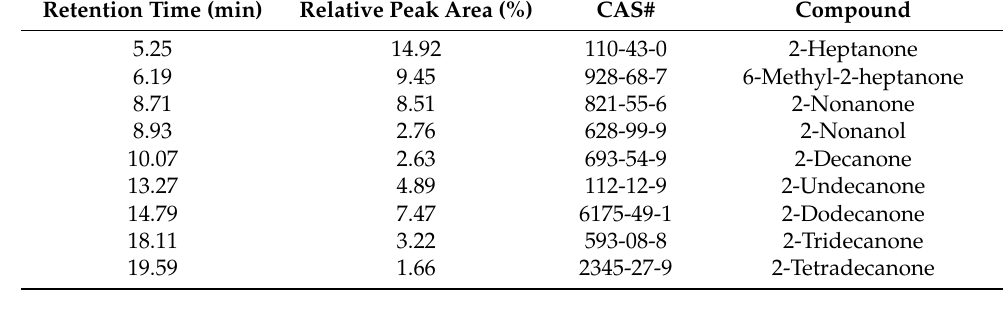
Table 3. GC–MS/MS VOC profile of Bacillus velezensis SBB.